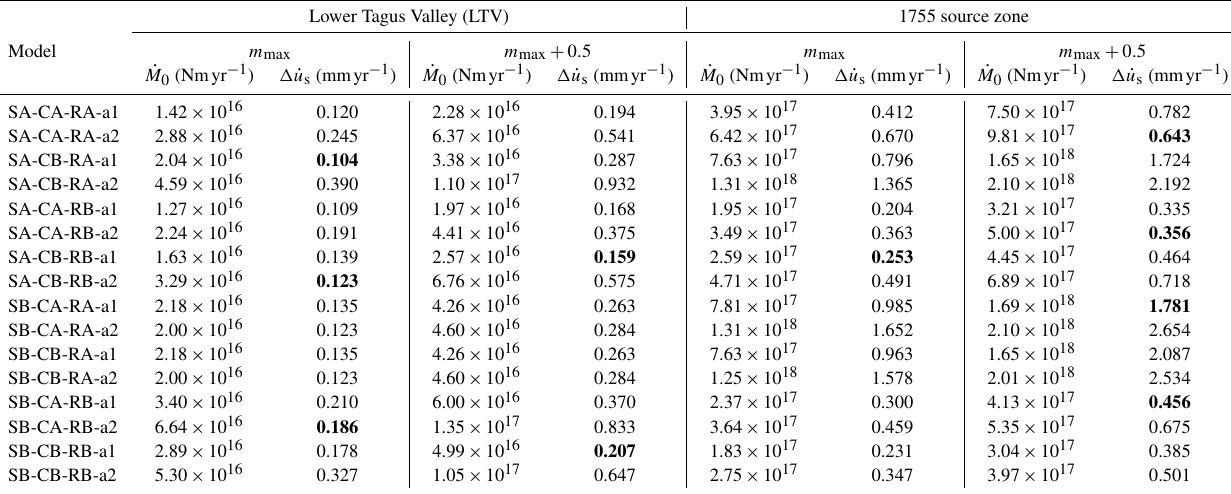
Table 9. Simple test: seismic deformation rates ( (cid:49) ˙ u s ) in millimetres per year (mmyr − 1 ) for the LTV and 1755 source zones, considering Vilanova and Fonseca’s (2007) 32 models resulting from the logic tree proposal. In bold we identify the recurrence models and values that will be checked by the complex sanity test. ˙ M 0 is the long-term seismic moment